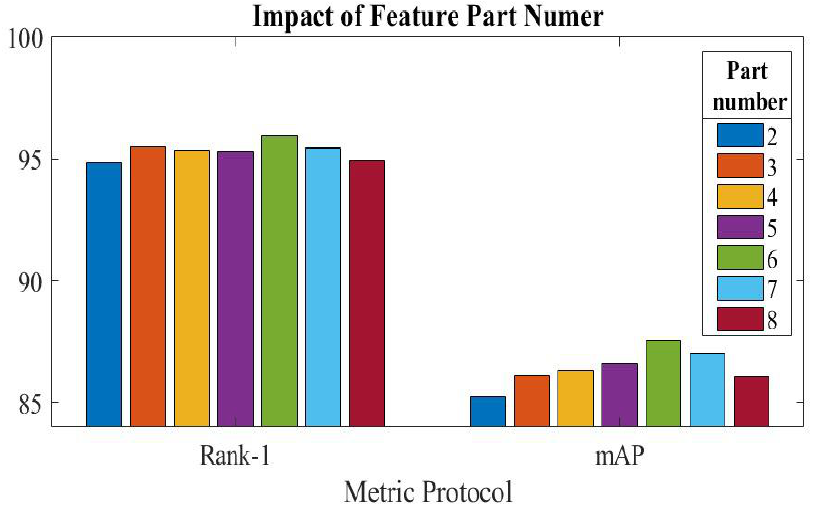
Figure 5. Performance of our proposed models under different feature part